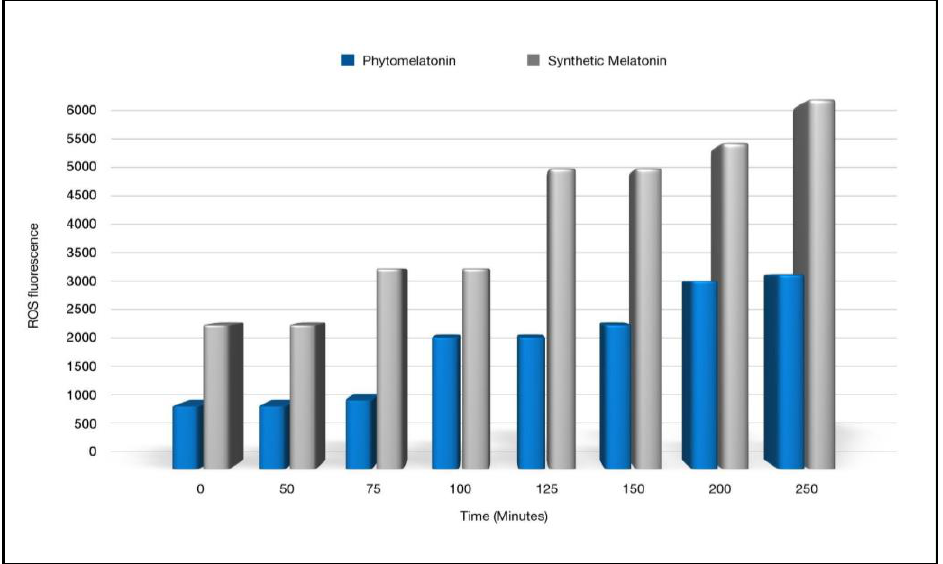
Figure 5. ROS fluorescence in human skin cell line by phytomelatonin (blue bars) and synthetic melatonin (gray bars). Data are expressed as ROS fluorescence using 50 mcg/mL for both phytomelatonin and synthetic melatonin. Values are derived from the original data presented in [34].